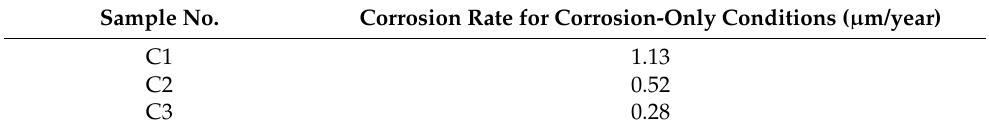
Table 4. Average corrosion rates of three samples.